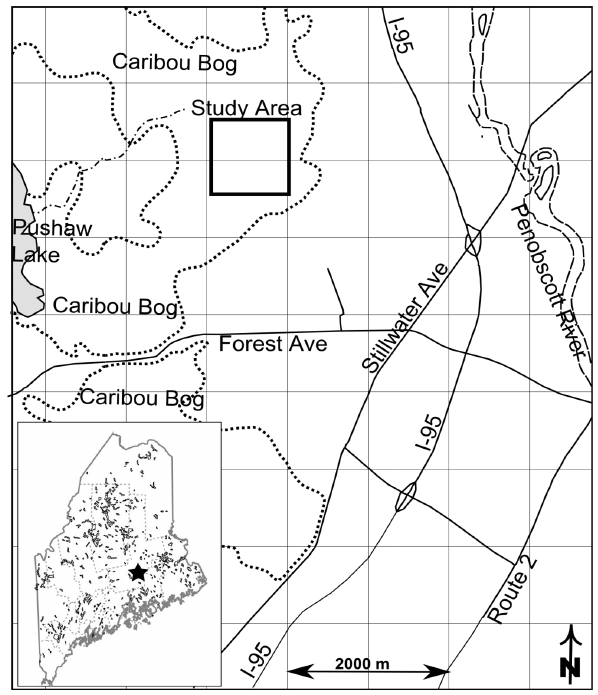
Fig. 2. Map of central and southern portion of Caribou Bog (out- lined by dashed line), a multiunit peatland, with study area in the central unit highlighted by the black box. The study area is shown enlarged in Fig.